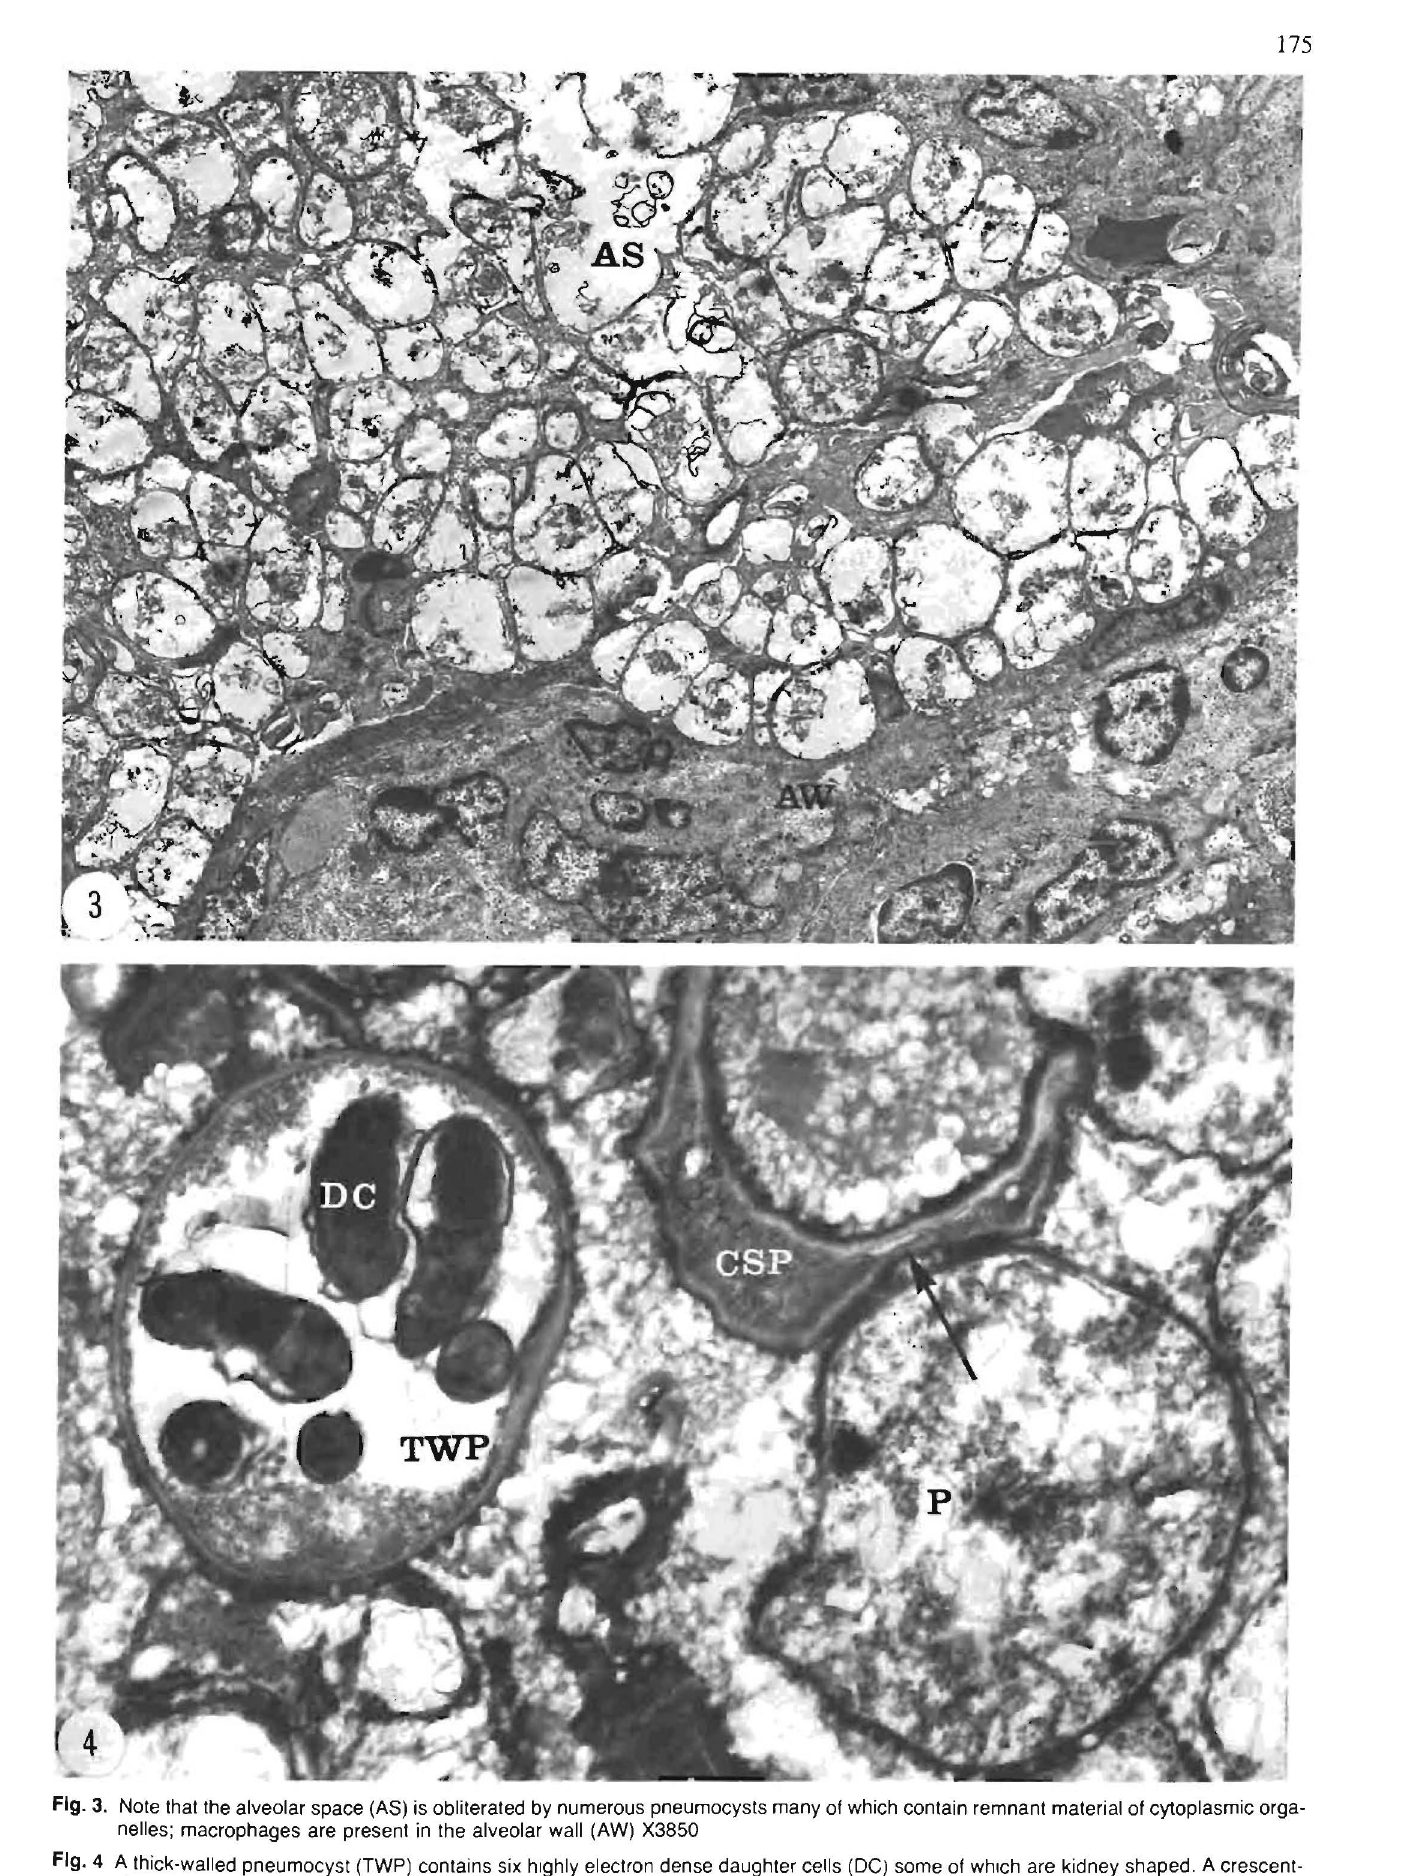
JOURNAL OF THE SOUTH AFRICAN VETERINARY